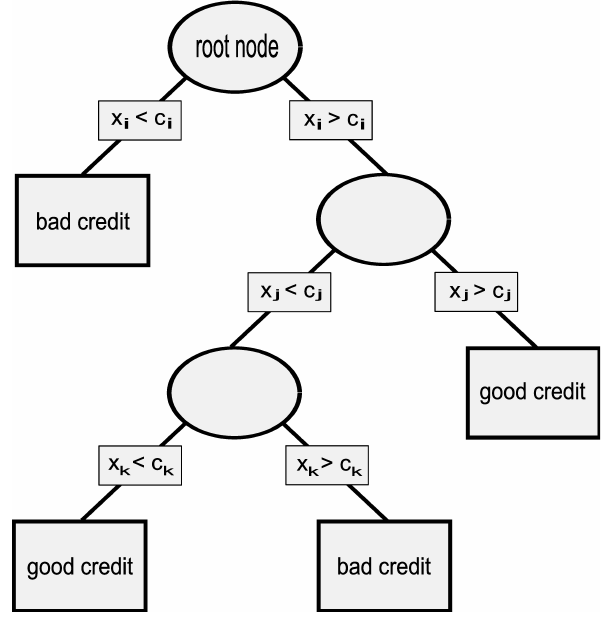
Figure 1. Illustration of a decision tree for credit